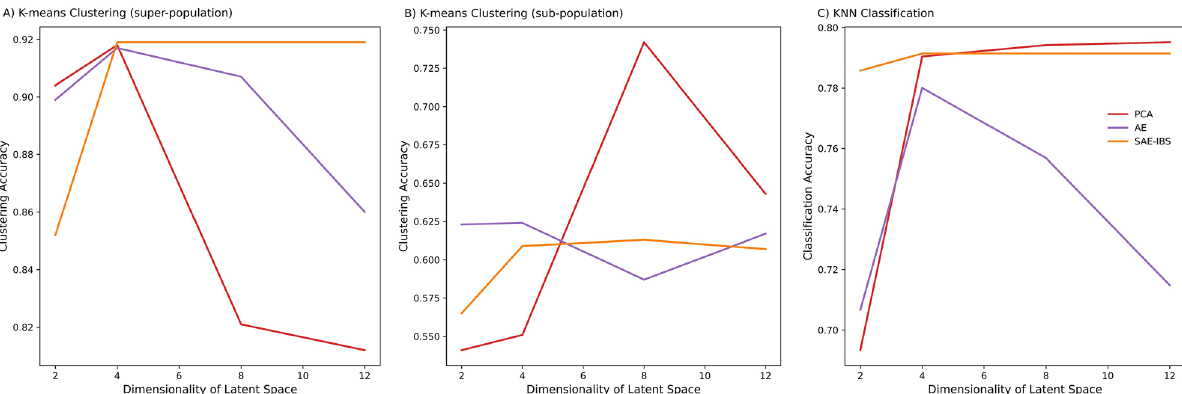
Figure 4. Comparison of clustering and classification accuracy under different latent space dimensions of different models. Number of clusters in K-means algorithm was set to 5 ( A ) and 26 ( B ), corresponding to the number of super-populations and sub-populations defined in the 1KGP dataset, respectively. ( C ) Number of neighbors in KNN classification was set to